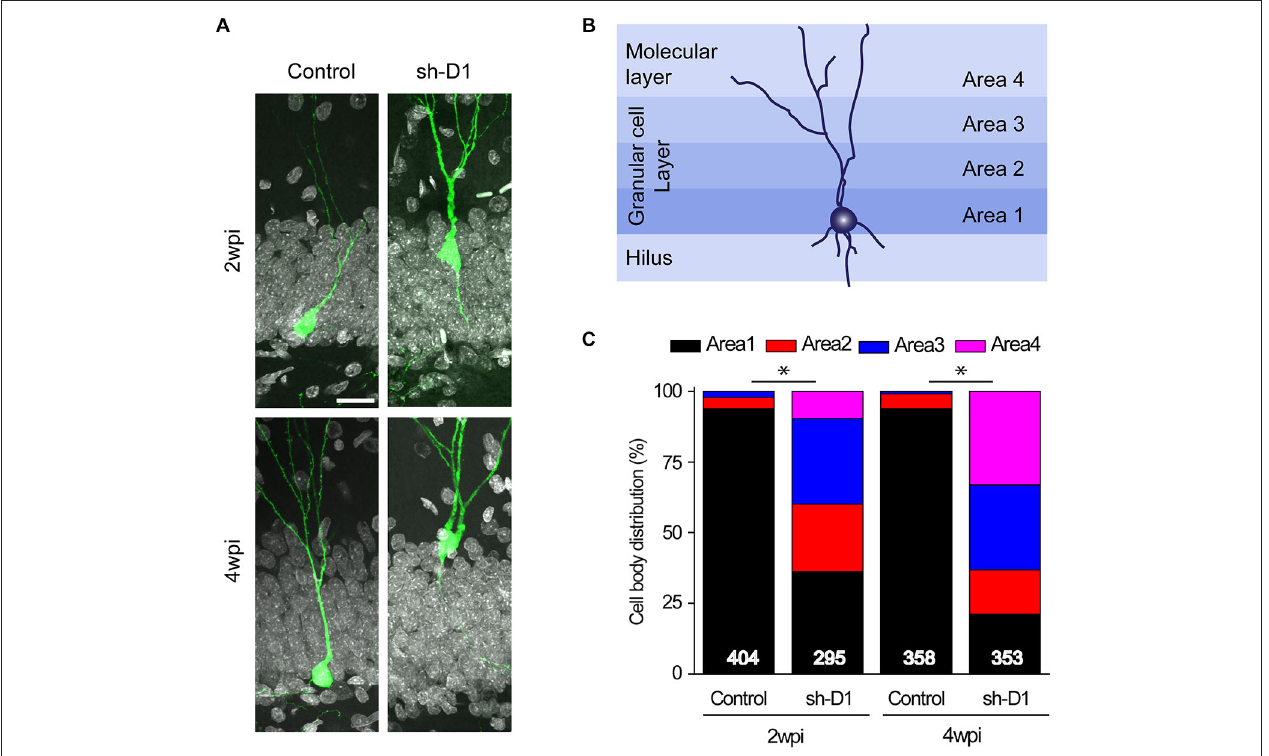
cells within each area as defined in (B) . Numbers indicated in each bar graph represent the total number of neurons analyzed from 3–8 animals under each condition (2 wpi: control, n = 404, sh-D1, n = 295; 4 wpi: control, n = 358, sh-D1, n =